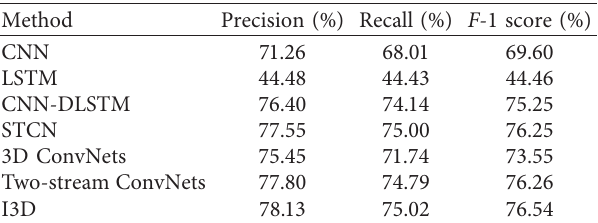
Table 5: Performance measures of different action recognition methods.